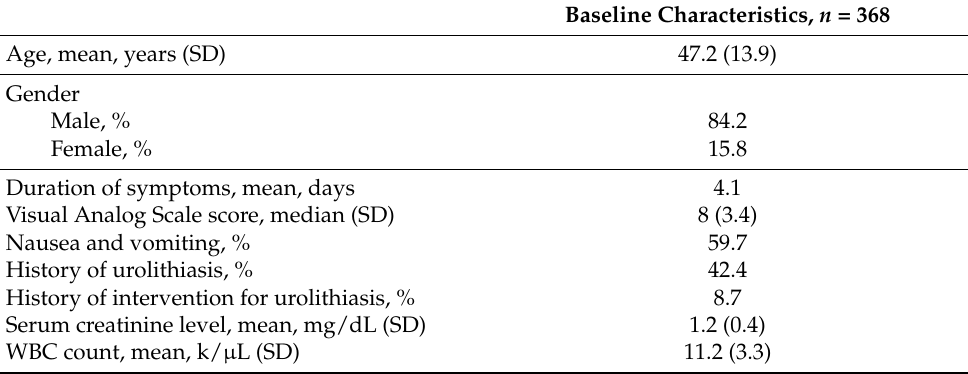
Baseline characteristics of entire cohort of patients (SD = standard deviation; IQR = interquartile